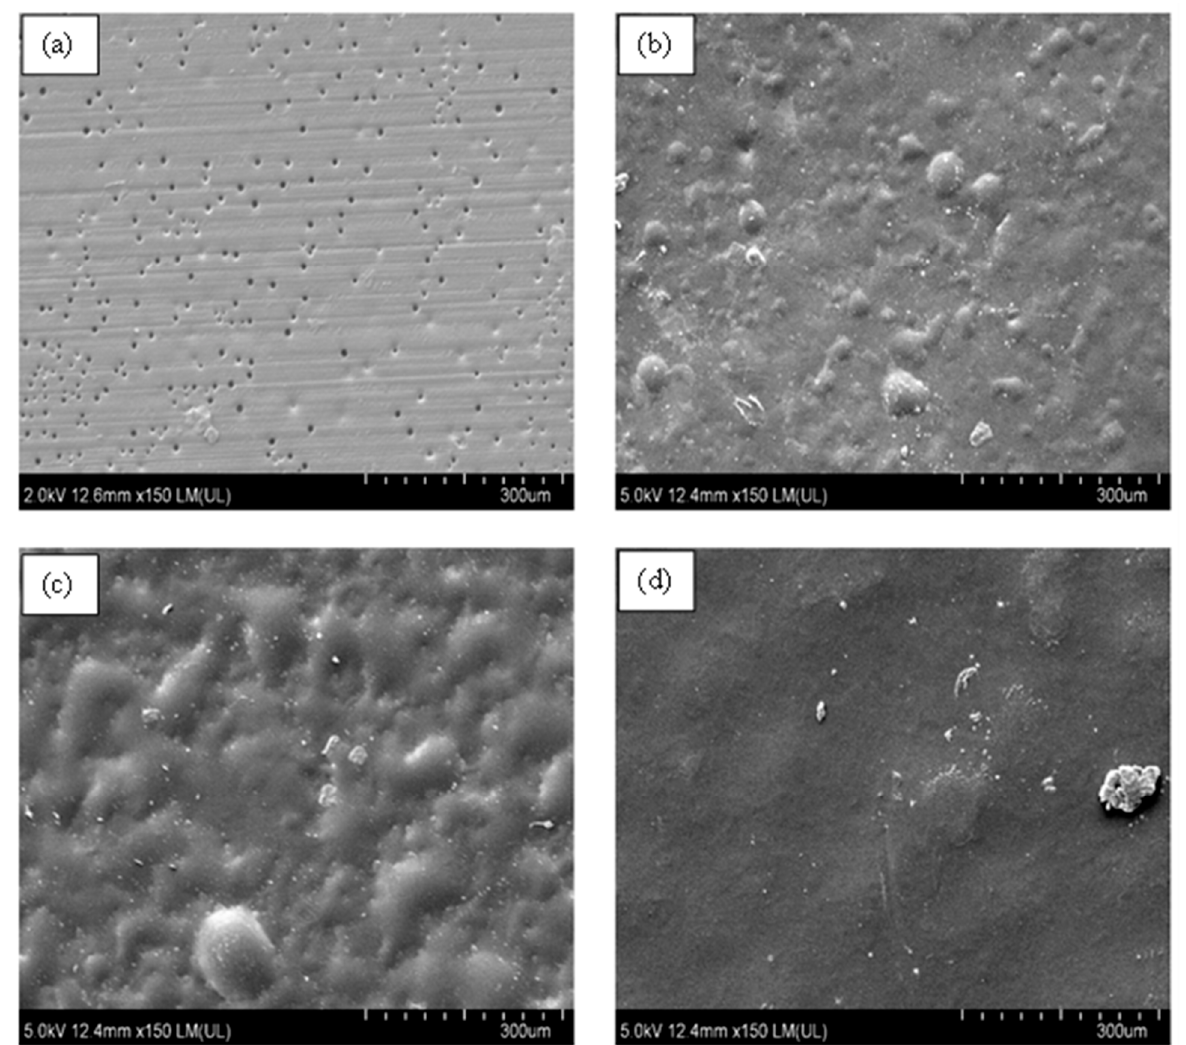
Figure 13. PU surface at magnification of × 150 with ( a ) 0.2% MWCNTs, ( b ) 0.4% MWCNTs, ( c ) 0.6% MWCNTs, and ( d ) 1% MWCNTs.